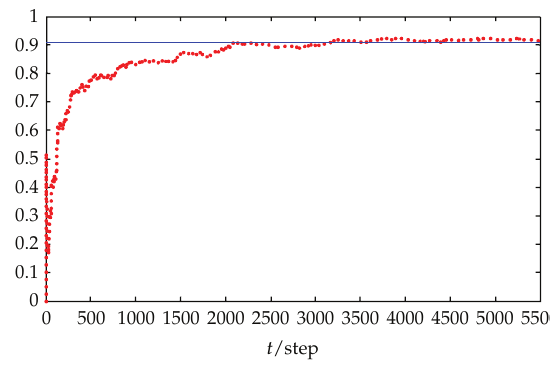
(cid:11) Q ε 1 (cid:5) t (cid:6) .